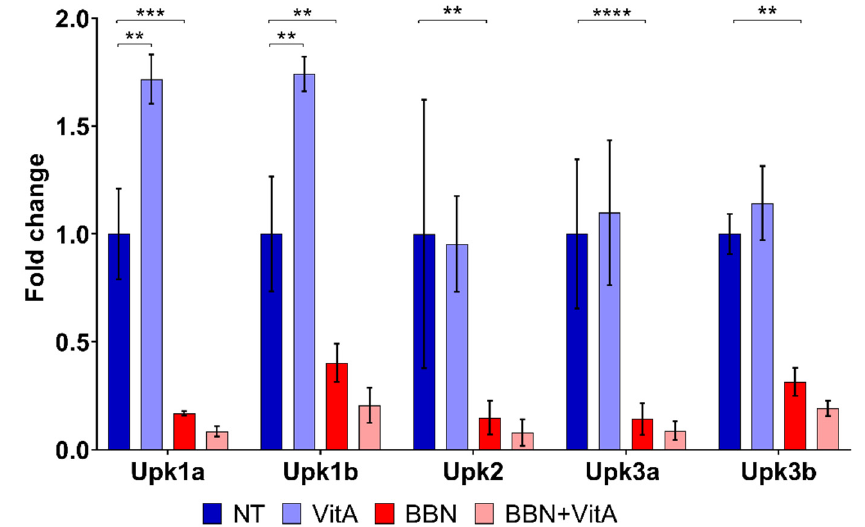
Figure 3. Transcriptional expression profiles of uroplakin genes ( Upk1a , Upk1b , Upk2 , Upk3a , and Upk3b